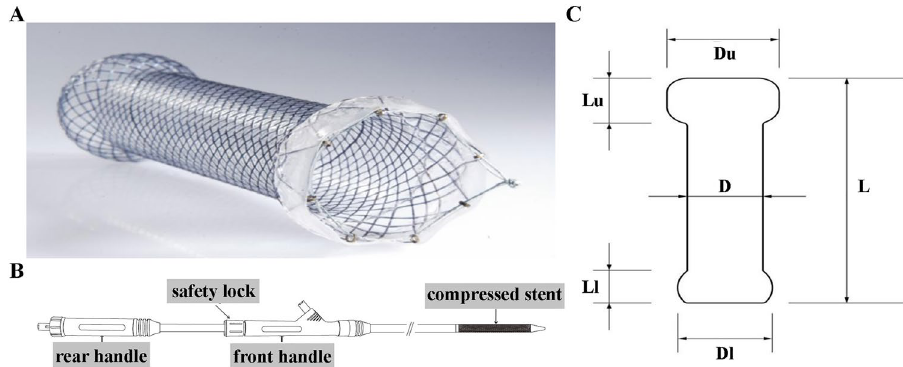
Figure 1. The nitinol fully covered self-expandable metal stents (FCSEMS), the stent delivery device and design, and characterization of this type of stent: Du and Lu are the diameter and length of the upper bell mouth, respectively. Dl and Ll are the diameter and length of the lower bell mouth,